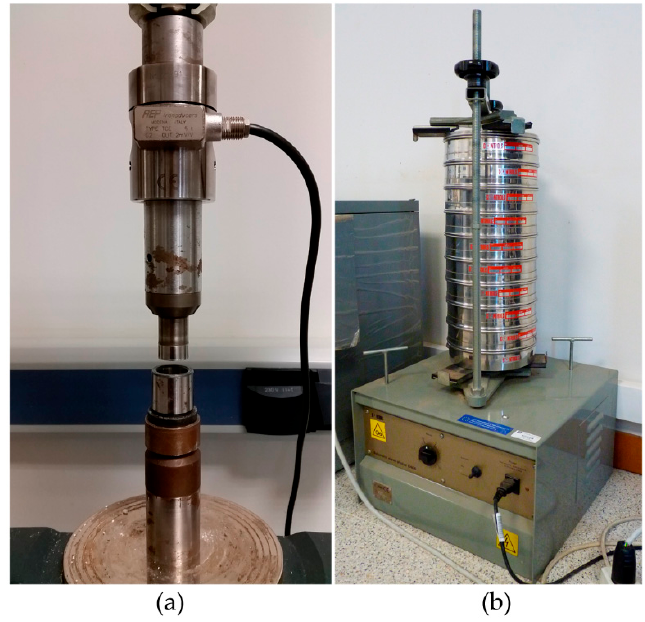
Figure 1. Equipment used in experiments. ( a ) Triaxial machine adapted to the compaction process. ( b ) Mechanical shaker with the sieves used for the gradation test.